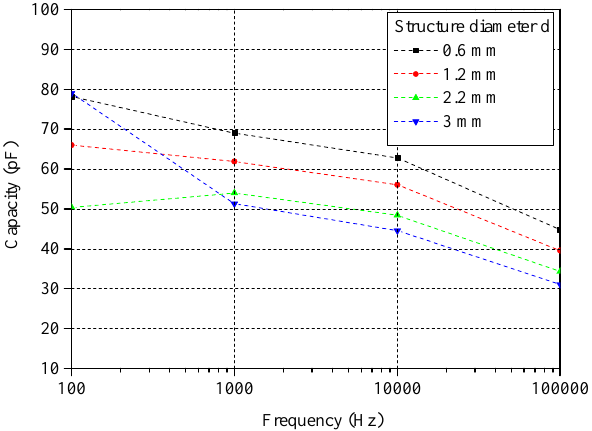
Figure 3. Characterisation of capacity at selected structure diameters ( d ) with different path widths ( a ) and distances ( b ) listed in Table 1 in the frequency range of 100–100kHz (without sensitive material).